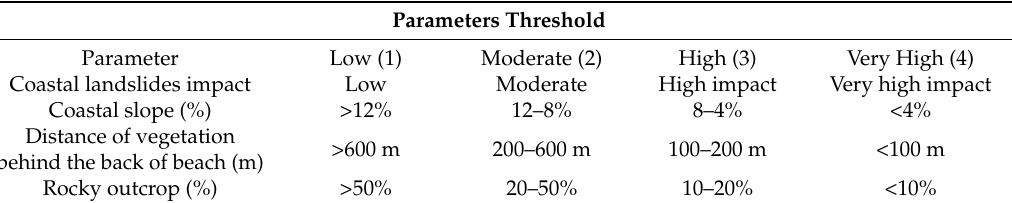
Figure 2. Coastal cell measurement on a shoreline. Table 3. Parameters and ranking.